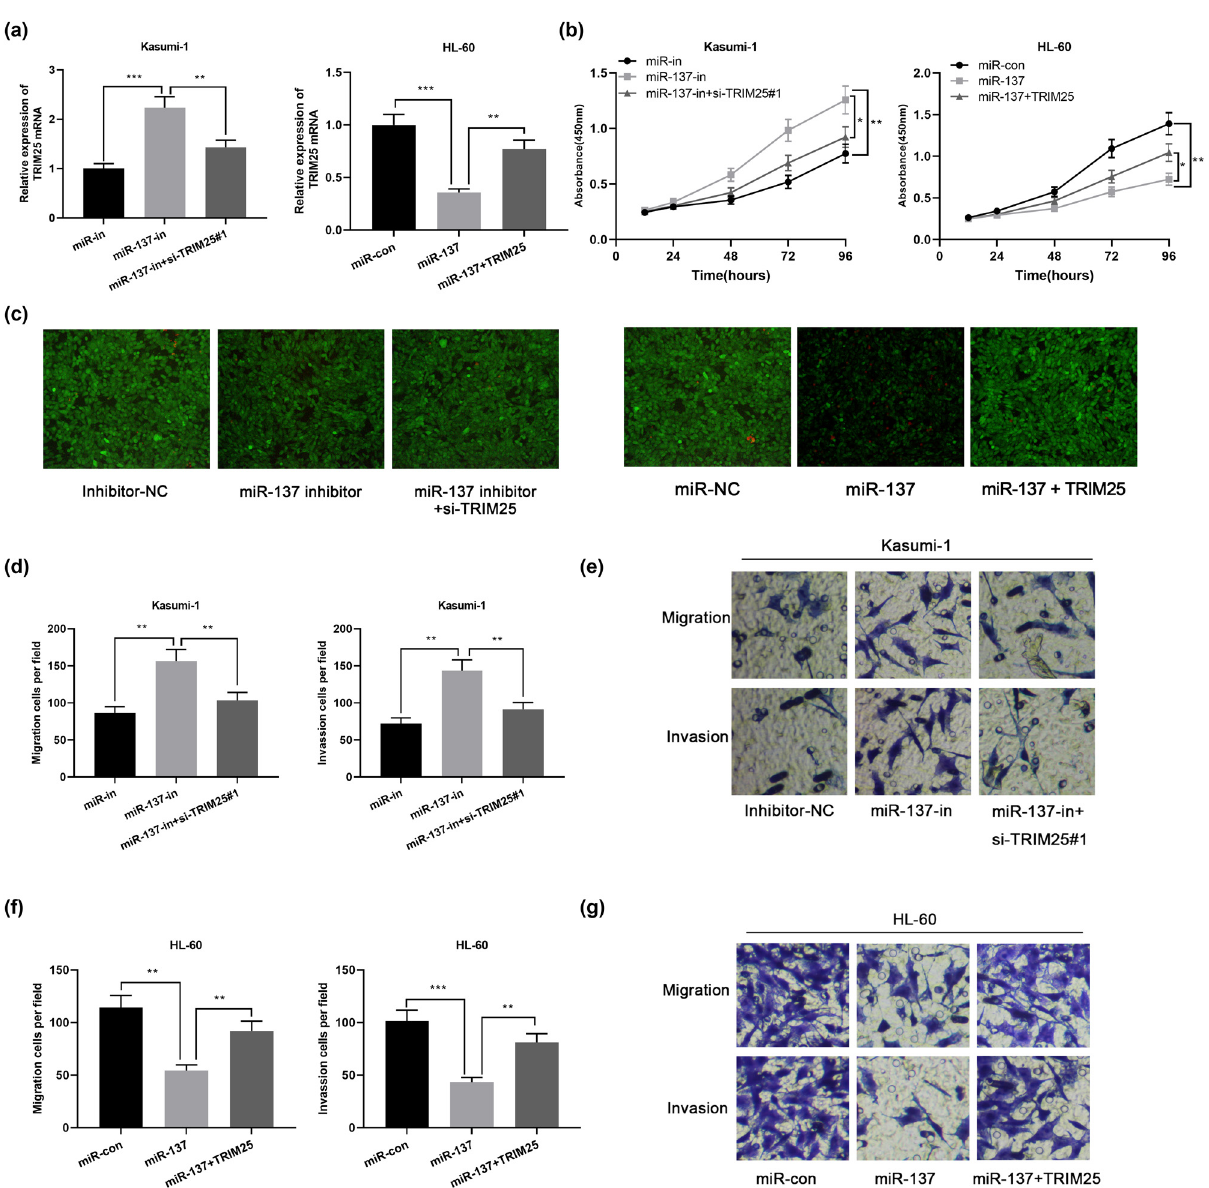
Figure 4: miR - 137 inhibited AML cell ’ s proliferation and migration by targeting TRIM25. ( a ) qPCR to detect TRIM25 mRNA expression in Kasumi - 1 cells transfected with miR - 137 inhibitor or co - transfected with si - TRIM25#1 and HL - 60 cells transfected with miR - 137 mimics or co - transfected with TRIM25. ( b ) CCK - 8 assay was performed to detect cell proliferation. ( c ) Cell viability was visualized by staining the cytoplasm with a live cell indicator, Calcein - AM ( green ) . Scale bar = 100 µm. ( d – g ) Transwell assay to detect cell migration and invasion. * P < 0.05, ** P < 0.01, *** P <